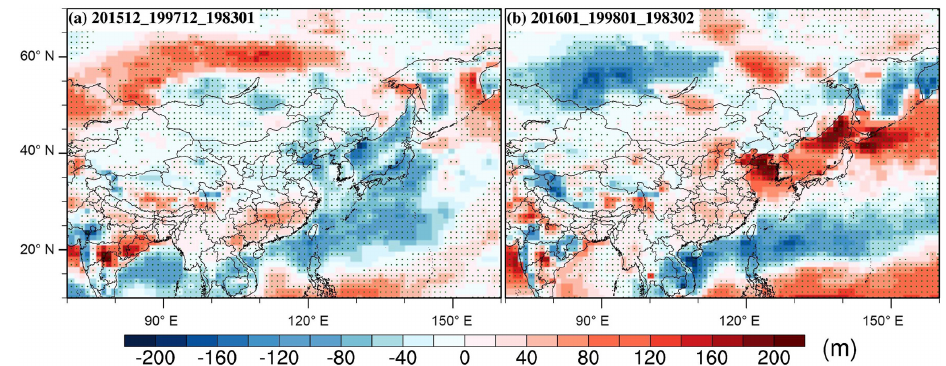
Figure 8. Sub-seasonal changes of the PBL height anomaly (relative to 1987–2016). The anomaly was conducted over the respective month from 1987 to 2016, i.e., the mean value of the anomaly over December 2015, December 1997 and January 1983 (a) and over January 2016, January 1998 and February 1983 (b) . Stippled areas indicate exceedance of the 90th confidence interval, using the same method as in Fig. 3.